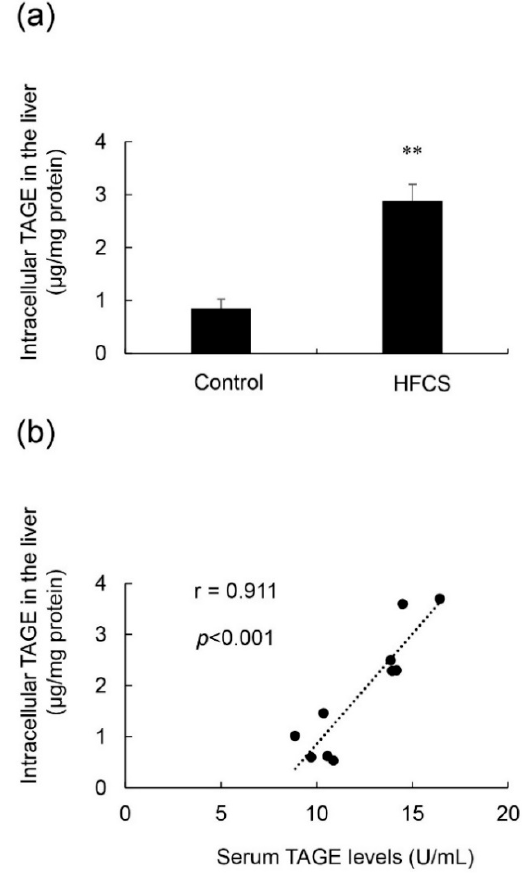
Figure 5. Calculation of intracellular TAGE levels in the liver, and the relationship between intracellular TAGE and serum TAGE levels. ( a ) Control; control group ( n = 5), HFCS; HFCS group ( n = 5). Tissue lysates (10 µ g of protein / lane) were loaded on the PVDF membrane, and proteins were probed with the anti-TAGE antibody or neutralized anti-TAGE antibody. The amount of TAGE was calculated based on a standard curve for TAGE-BSA. Data are shown as means ± S.E. ( n = 5). p -Values were based on the Mann-Whitney U-test. ** p < 0.01 vs. control. ( b ) Relationship between intracellular TAGE levels in the liver and serum levels of TAGE ( n = 10).